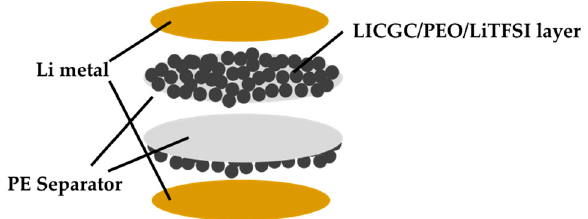
Figure 3. Configuration of the Li/Li symmetric cell using the LICGC/PEO/LiTFSI-PE separator.